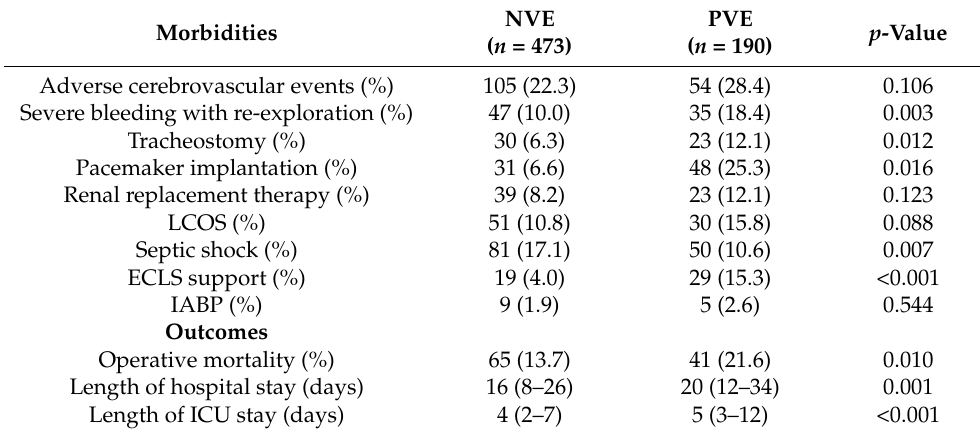
Table 2. Postoperative complications and outcomes. Data are presented as medians